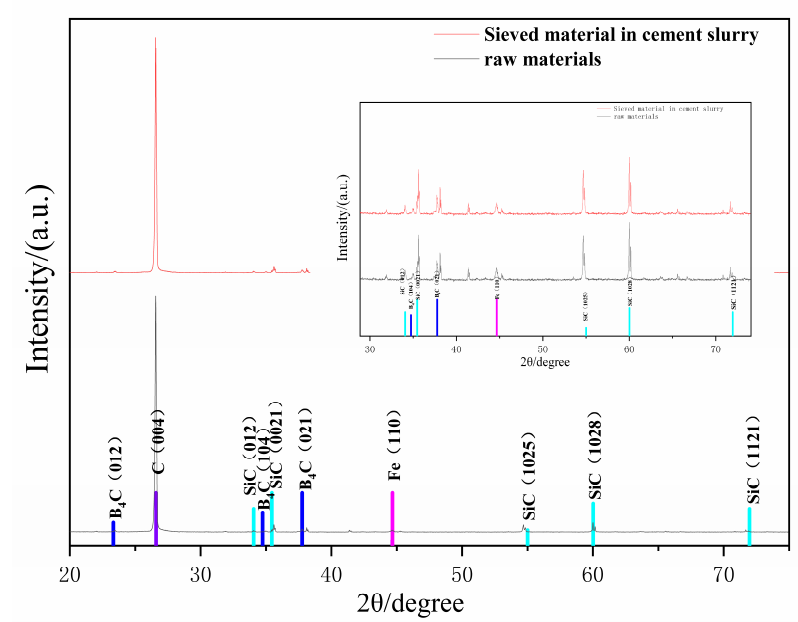
Figure 2. XRD results of the tagged material mixture with the sieve